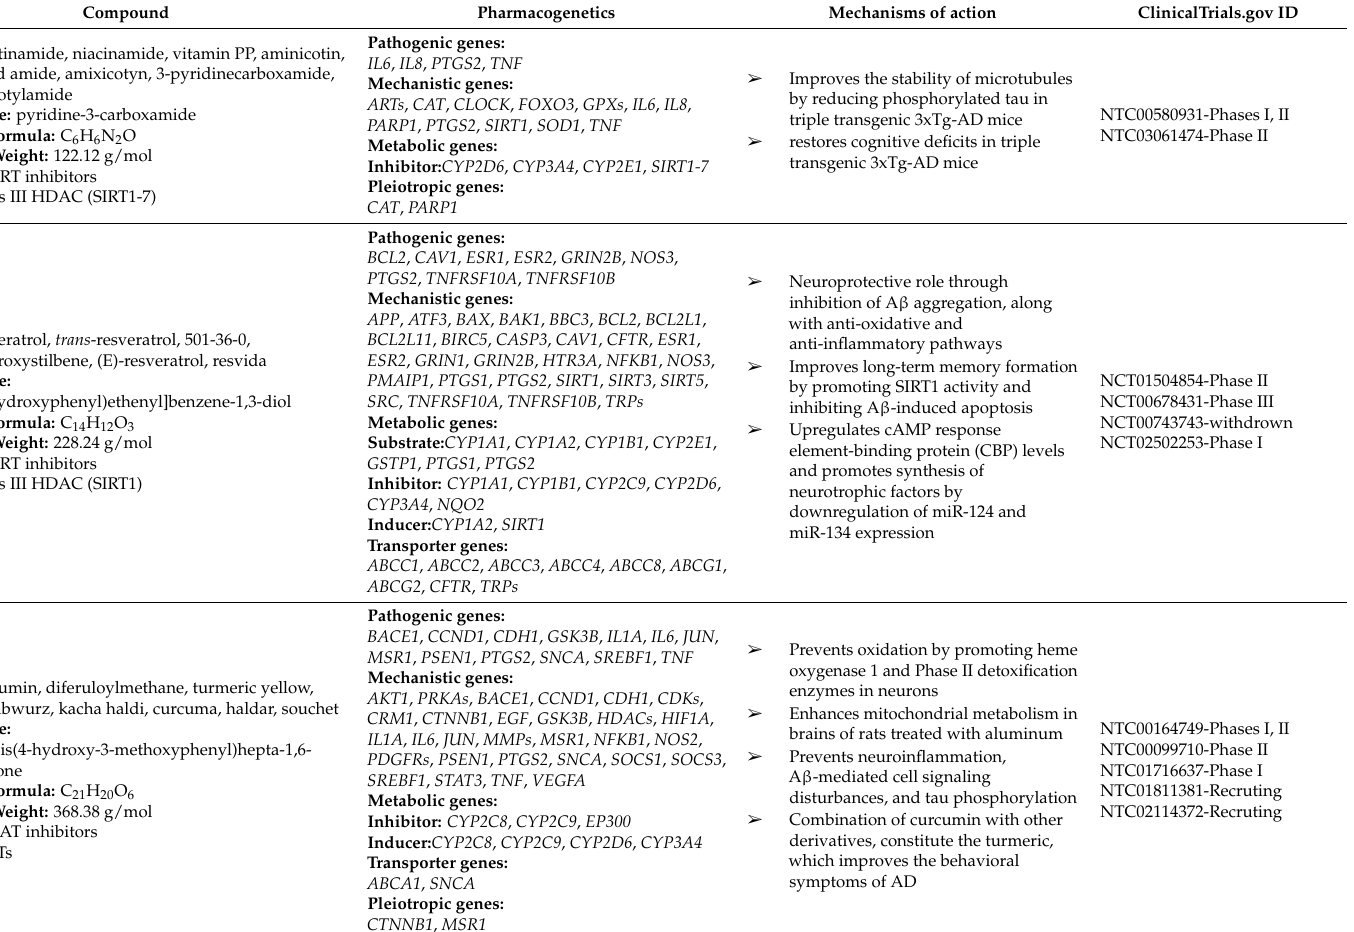
NTC00164749-Phases I, II NTC00099710-Phase II NTC01716637-Phase I NTC01811381-Recruting